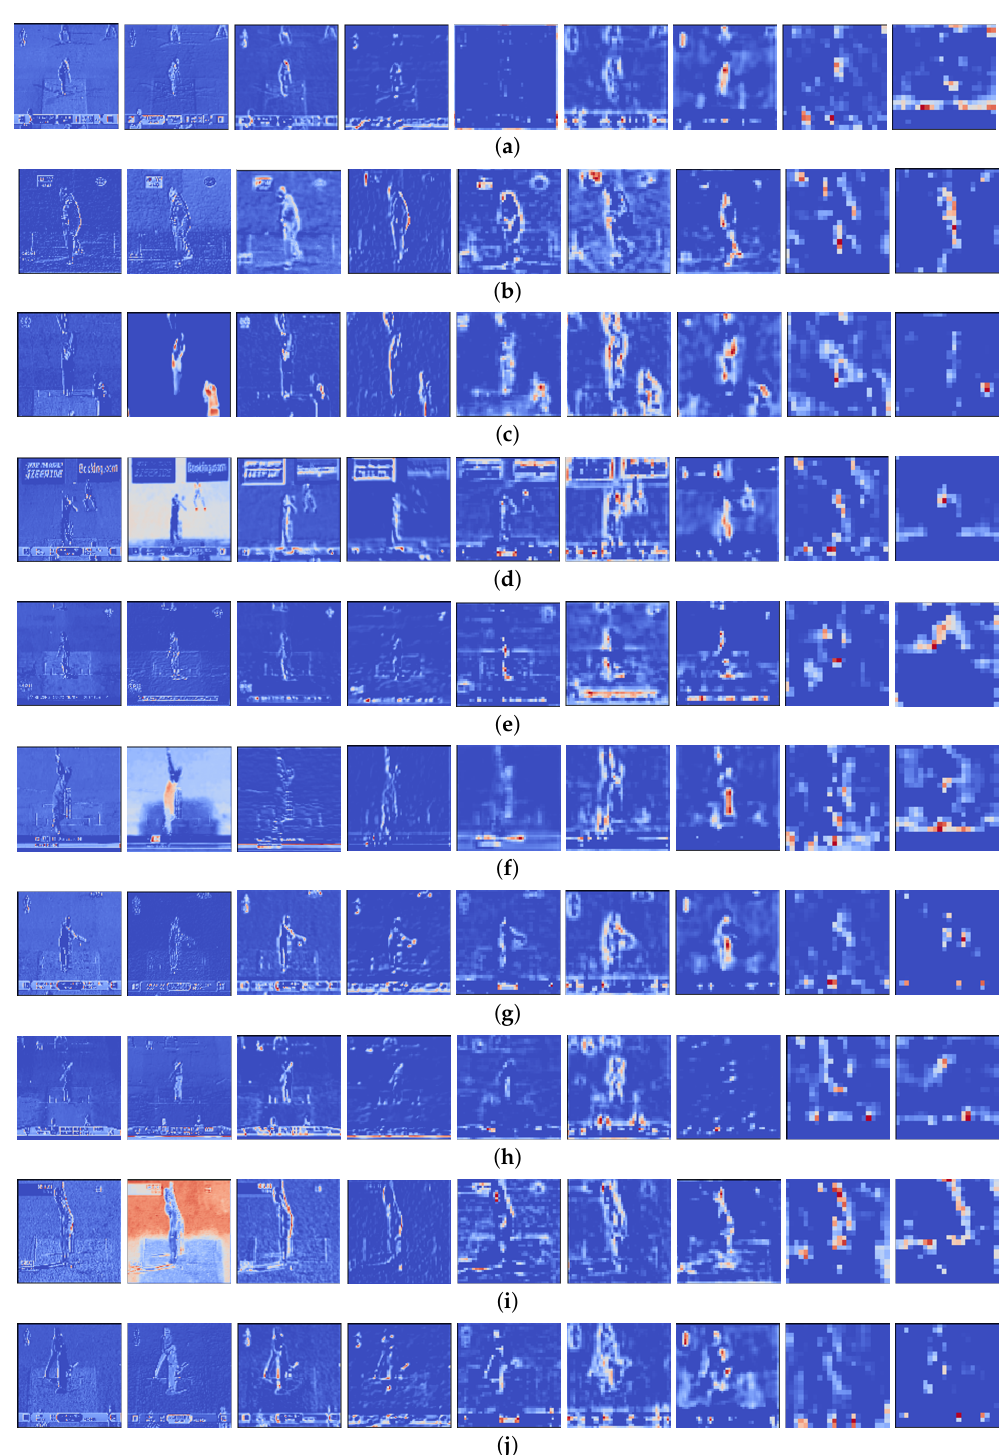
Figure 9. Low- to high-level feature maps using VGG16 for different batting shots: ( a ) cover drive, ( b ) defensive shot, ( c ) flick, ( d ) hook shot, ( e ) late cut, ( f ) lofted shot, ( g ) pull shot, ( h ) square cut, ( i ) straight drive, ( j ) sweep